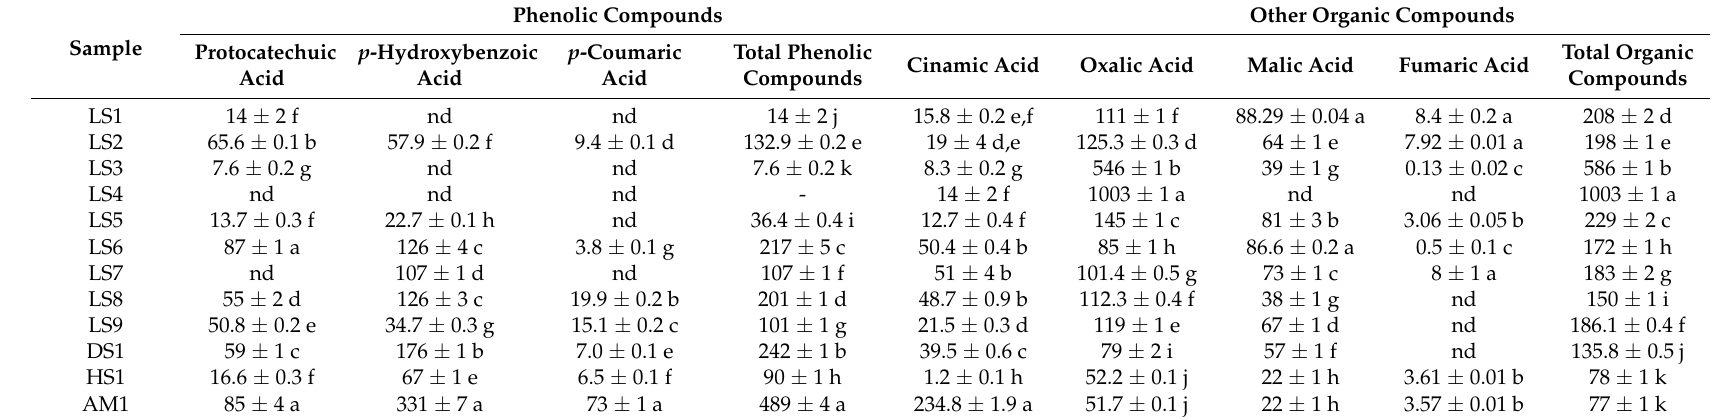
Table 3. Composition in phenolic compounds ( µ g/100 g · dw) and organic acids (mg/100 g · dw) of the studied wild